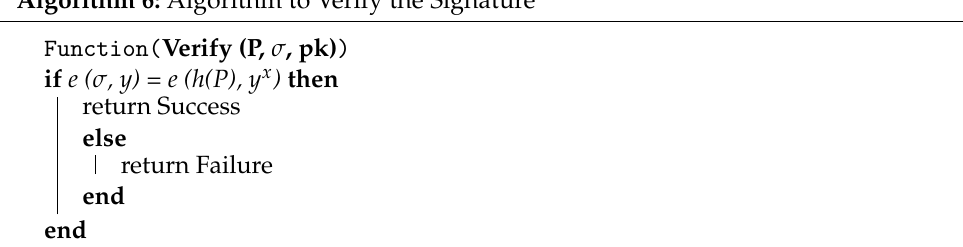
Algorithm 6: Algorithm to Verify the